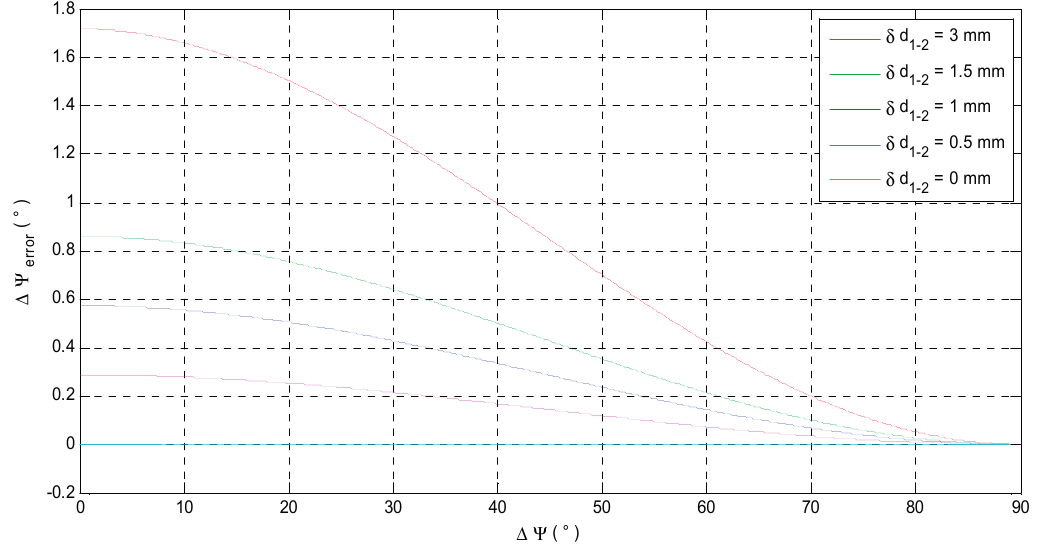
Figure 6. The effect of ψ Δ on the ψ